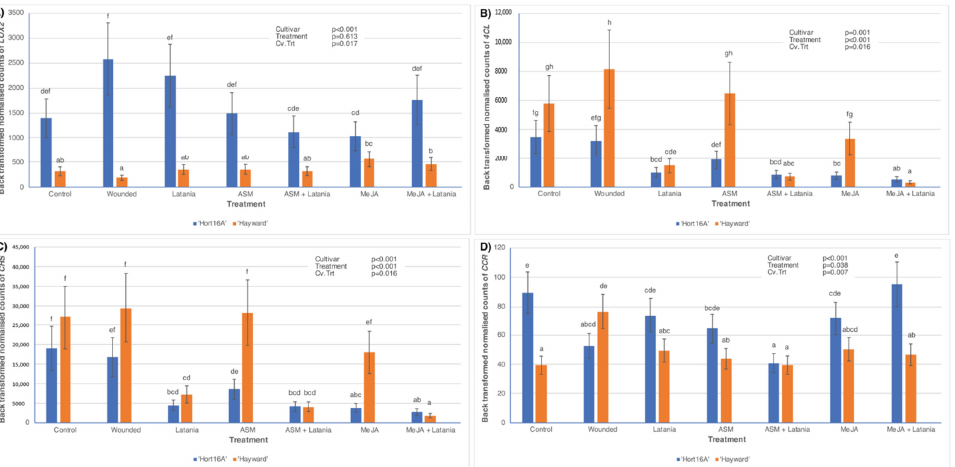
Figure 7. Defence gene expression measured by PlexSet ® NanoString in ‘Hort16A’ and ‘Hayward’ kiwifruit leaf tissue, in 2018, of jasmonic acid (JA) and phenylpropanoid pathway-related genes: